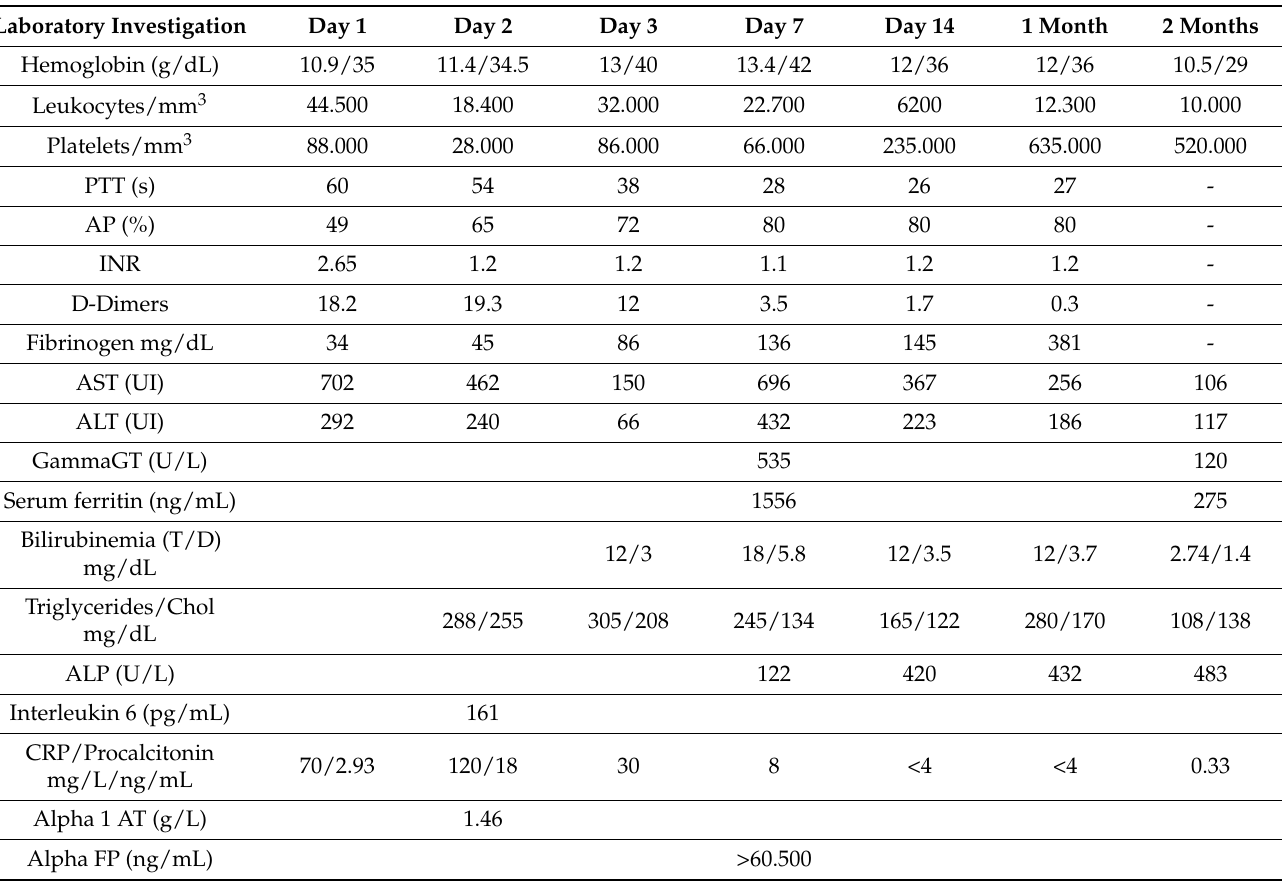
Figure 4. Cranial ultrasound at one month of age—Appearance of left periventricular leukomalacia, left porencephalic cyst. 3. Discussion Neonatal liver failure represents a major emergency due to the risk of death and late complications such as liver cirrhosis. This type of pathology with a very severe clinical picture poses great difficulty for the clinician because prompt diagnosis is the key to a higher survival rate. The diagnosis of congenital alloimmune hepatic impairment in our case was one of exclusion. Antenatal damage has been evident since the mother was admitted when cardiotocographic monitoring showed signs of fetal distress. The CTG monitoring showed a lack of variability in fetal heart rate (an element that may be the result of hypoxic damage to the fetal central nervous system by influencing the interaction between the sympathetic and parasympathetic nervous systems) [12]. Another element observed was the lack of a sleep cycle (“cycling”) that can hide a deficiency of the central nervous system regarding the regulation of heart rate [13]. Given that the mother was hospitalized shortly before birth, the appearance of CTG can also be considered as part of gradual hypoxia in the decompensated phase, when the variability disappears and the baseline decreases [14]. After analyzing all the causes of cholestatic hepatitis, when the patient was very severely affected and required urgent measures, we quickly eliminated the infectious causes in an early stage (early neonatal sepsis and congenital infections). HSV infection